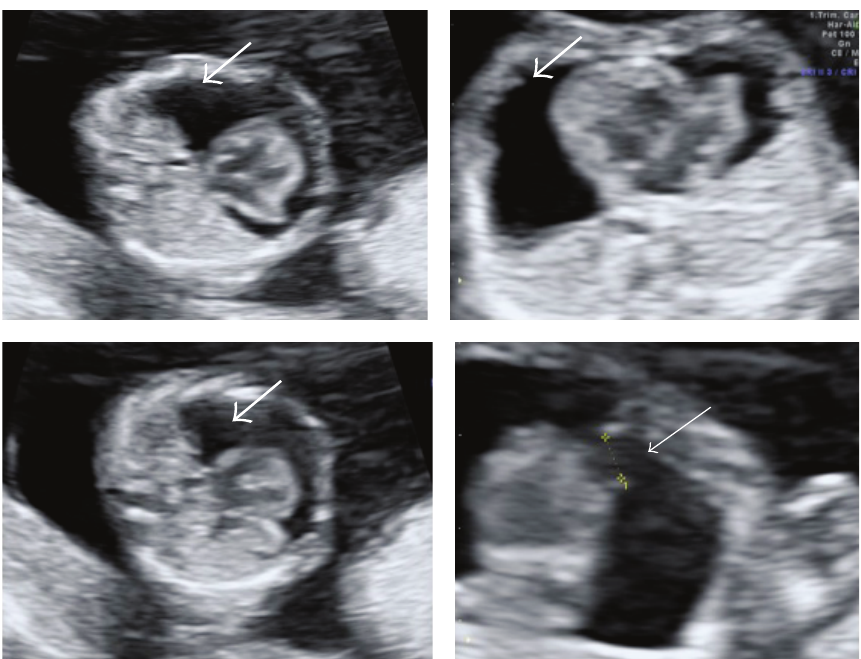
Figure 1: Transversal view of the thorax during the 14th week of pregnancy, where severe pericardial effusion (thick arrow) and cardiac diverticulum in the ventricular apex (thin arrow) can be observed.